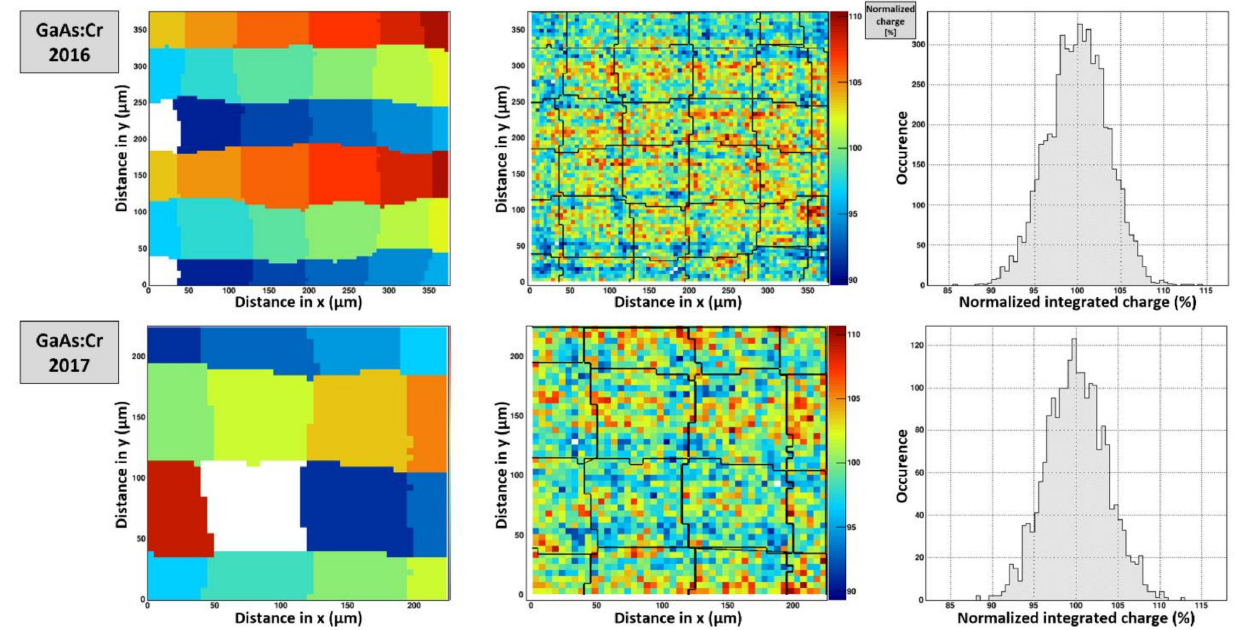
Figure 19. ( left ) The left plots show the merged pixel response map. At each scan point, the pixel with the highest charge is assigned as collecting pixel. ( center / right ) Charge collection map and histogram indicating the overall collected charge in all pixels for each scan point. The black lines are the overlaid pixel boundaries extracted from the photon counting representation (with an estimated error margin of ± 5 µ